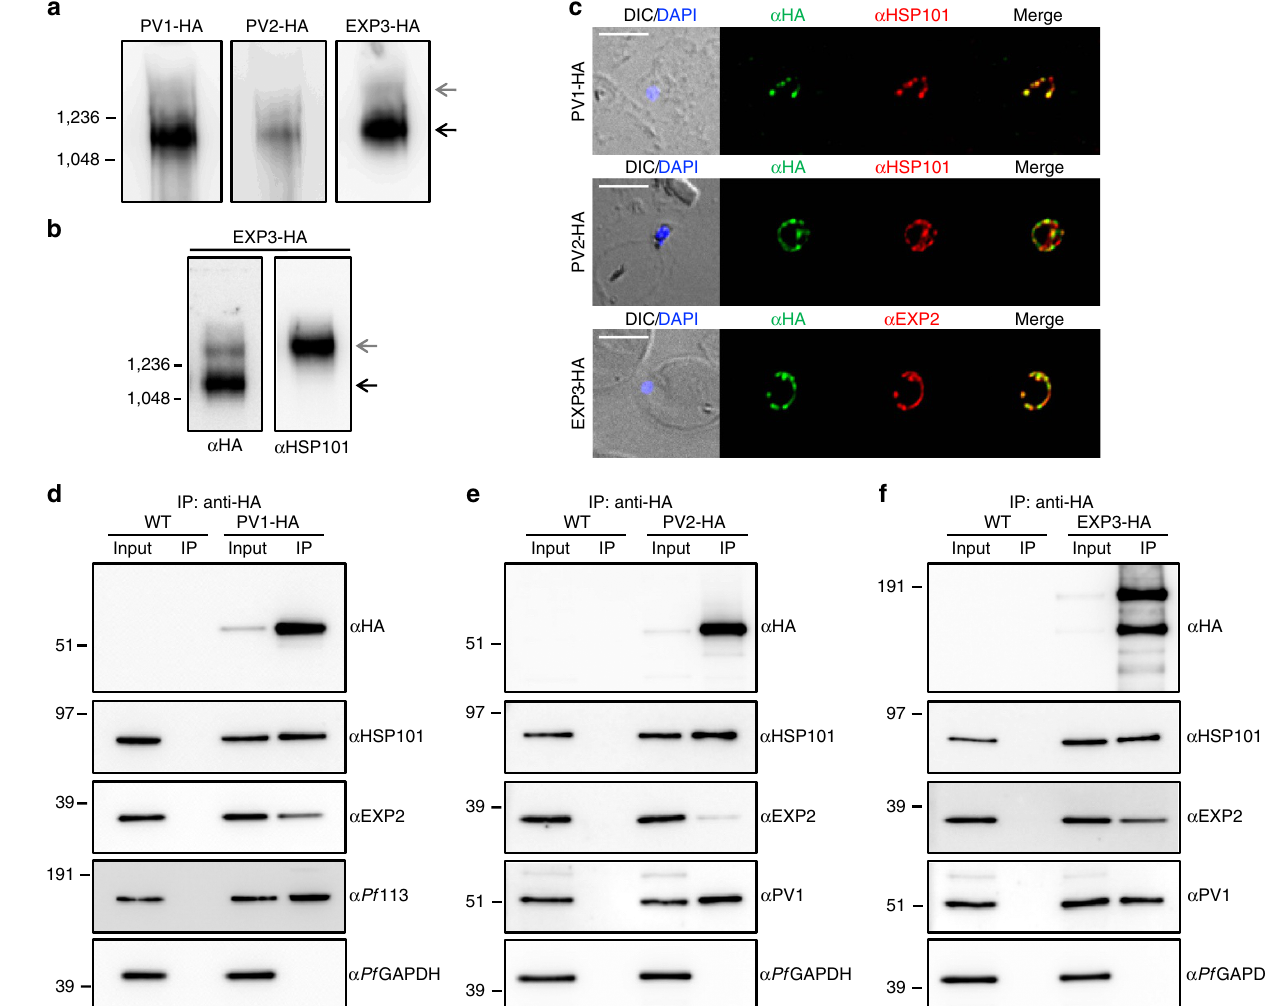
Figure 5 | Identification of a novel PV protein complex that interacts with PTEX. ( a , b ) Blue native (BN)-PAGE analysis of PV1-HA-, PV2-HA- and EXP3- HA-infected RBCs. Western blots were probed with ( a , b ) anti-HA and ( b ) anti-HSP101 antisera. Black and grey arrows indicate different size protein complexes. ( c ) Immunofluorescence analysis of PV1-HA-, PV2-HA- and EXP3-HA-infected RBCs labelled with antisera recognizing HA (green) and HSP101 or EXP2 (red). DIC and DAPI (blue) are shown on the left. Scale bars, 5 m m. ( d – f ) Immunoprecipitation of PV1-HA, PV2-HA and EXP3-HA parasite lysates using anti-HA-conjugated agarose beads. Total protein (input) and eluate (IP) were prepared for western blot and probed with ( d – f ) anti-HA, anti-HSP101, anti-EXP2, ( d ) anti- Pf 113 and ( e , f ) anti-PV1 antisera. Membranes were probed with anti- Pf GAPDH antisera as a negative control. ( a , b , d – f ) Molecular masses are shown in kDa. Uncropped western blots are shown in Supplementary Fig.